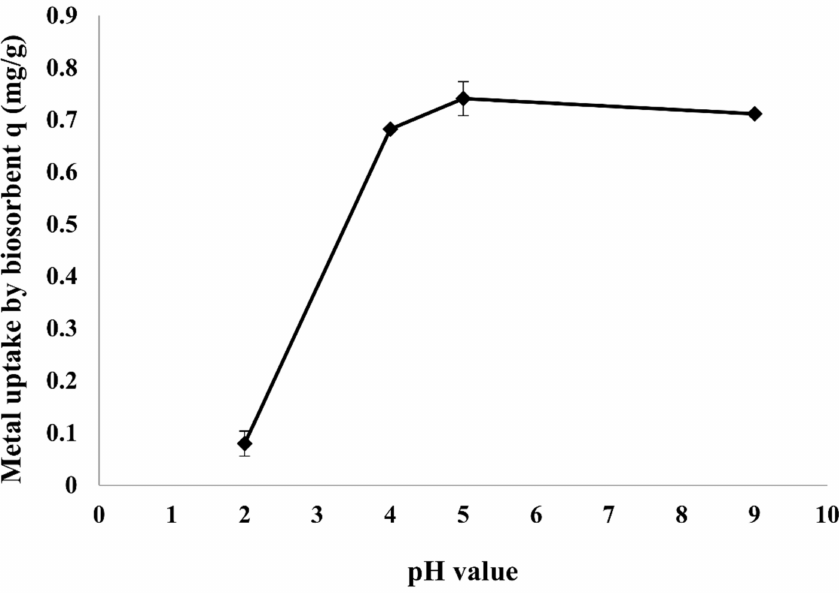
Figure 3. Effect of pH on the biosorption of Cd (pH: 4.0; temperature: 27 ◦ C; biomass dosage: 5 g/L; time: 3